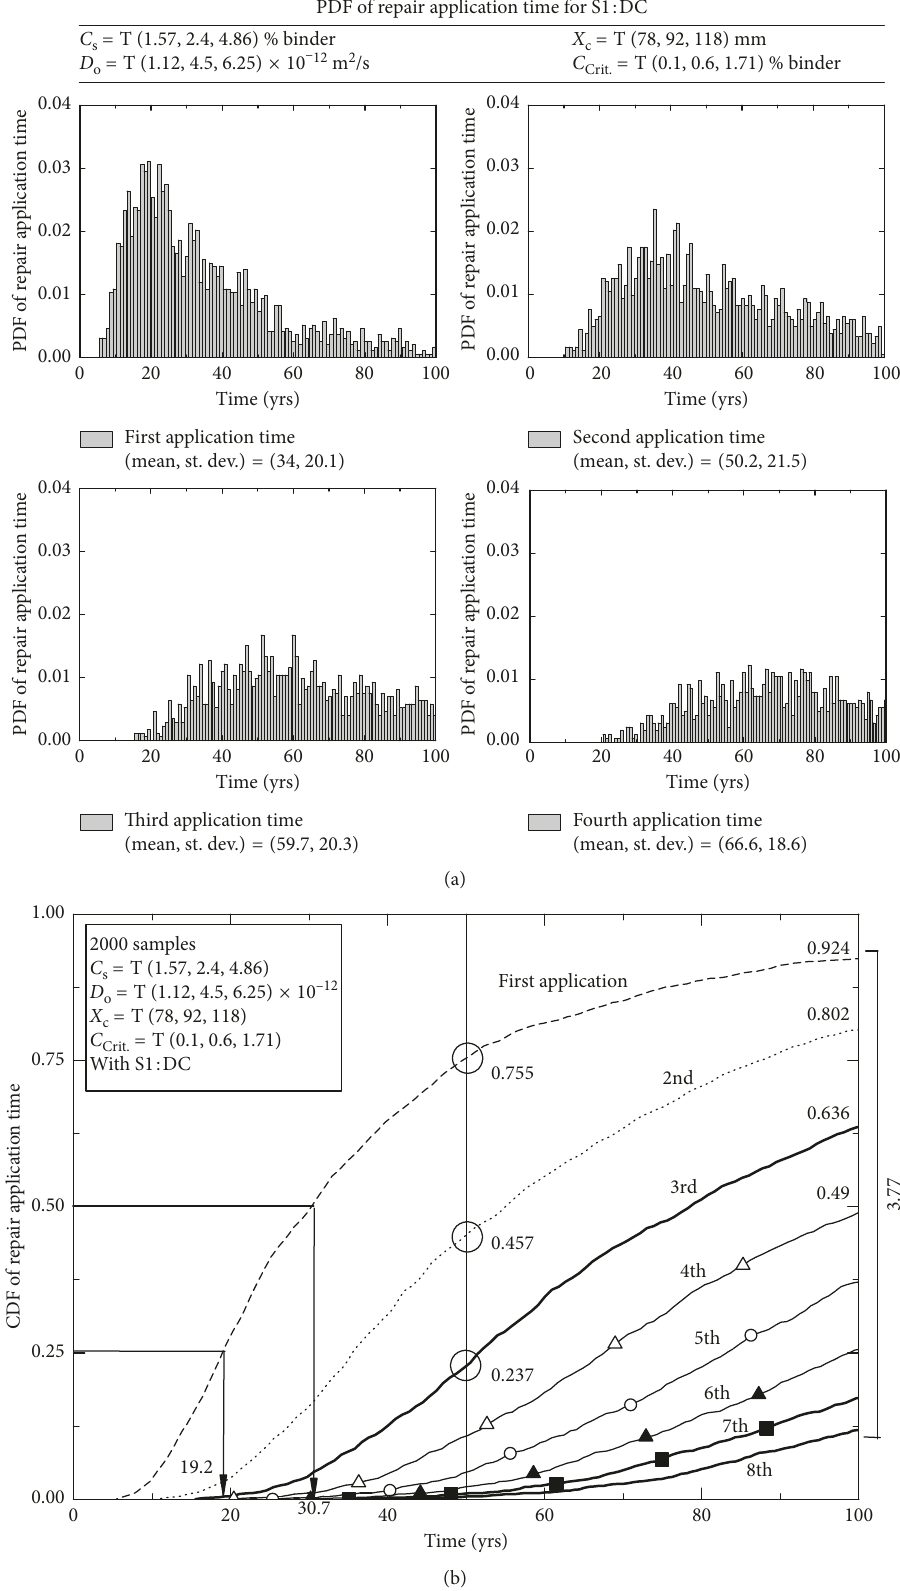
Figure 9: PDF and CDF of repair application time for S1. (a) PDF of repair application time. (b) CDF of repair application